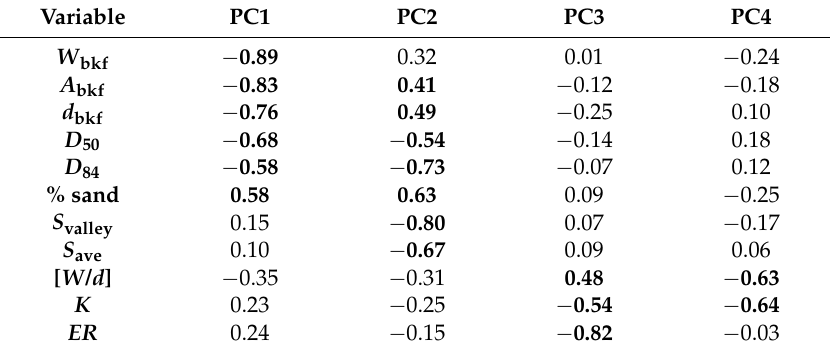
Table 3. PC weights for the first four PCs based on 11 morphology variables measured at 79 restored streams. Variables with higher weights are in